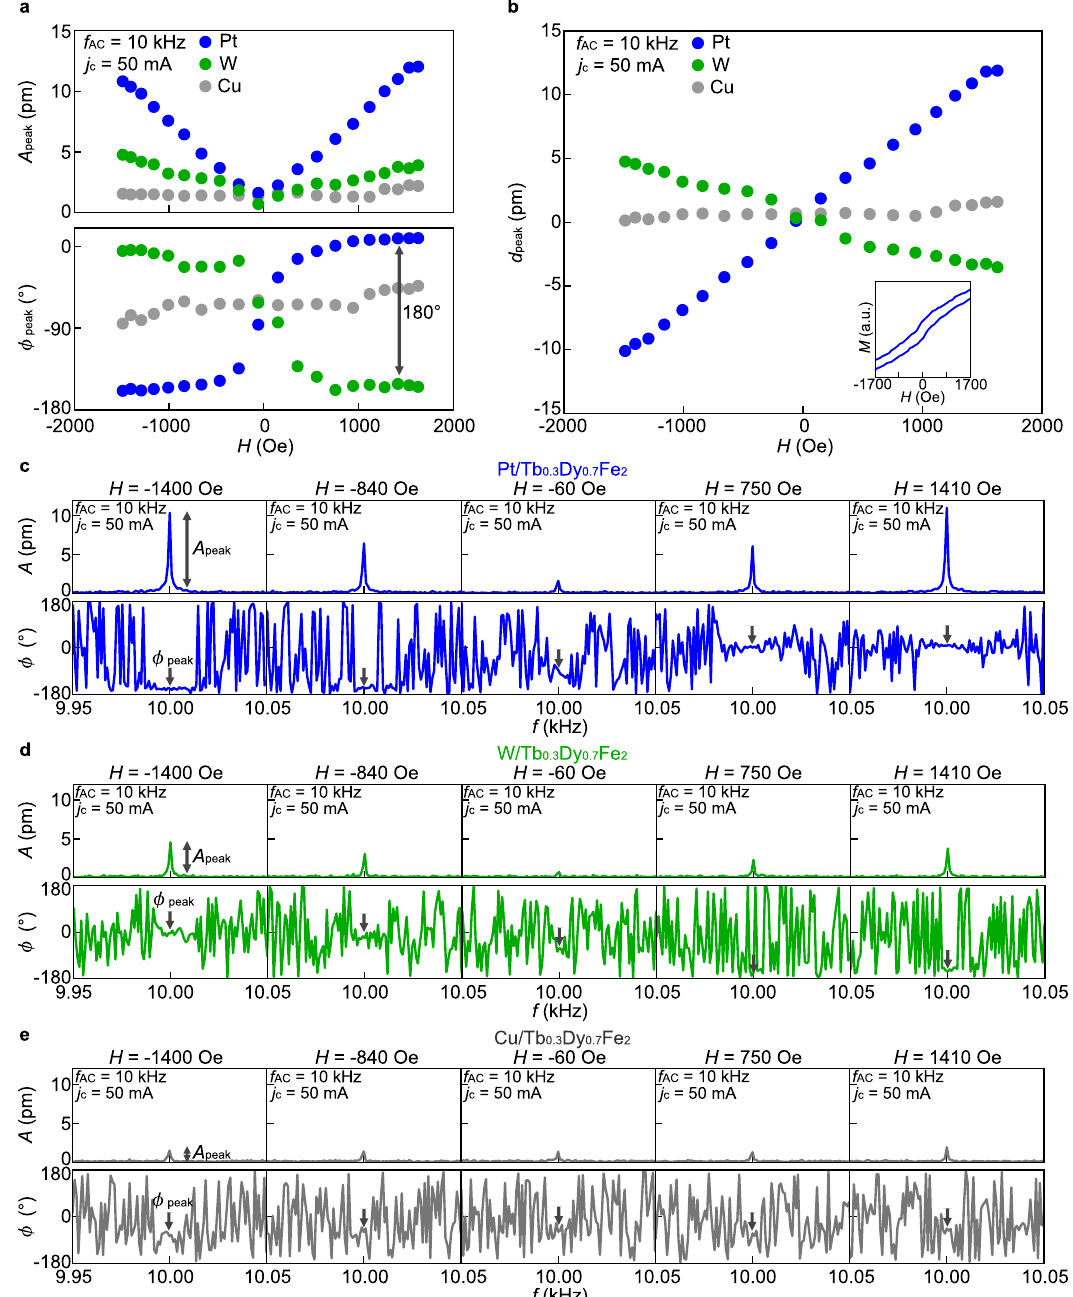
Fig. 3 Magnetic fi eld dependence of spin-current induced mechanical vibration. a The H dependence of A peak (upper panel) and ϕ peak (lower panel) for the Pt/Tb 0.3 Dy 0.7 Fe 2 (blue plots), W/Tb 0.3 Dy 0.7 Fe 2 (green plots), and Cu/Tb 0.3 Dy 0.7 Fe 2 (gray plots) samples. b The H dependence of d peak ¼ A peakcos ϕ peak for the Pt/Tb 0.3 Dy 0.7 Fe 2 (blue plots), W/Tb 0.3 Dy 0.7 Fe 2 (green plots), and Cu/Tb 0.3 Dy 0.7 Fe 2 (gray plots) samples. The inset shows the dependence of the magnetization M for the Pt/Tb 0.3 Dy 0.7 Fe 2 sample. c – e f spectra of A (upper panel) and ϕ (lower panel) at each H for the